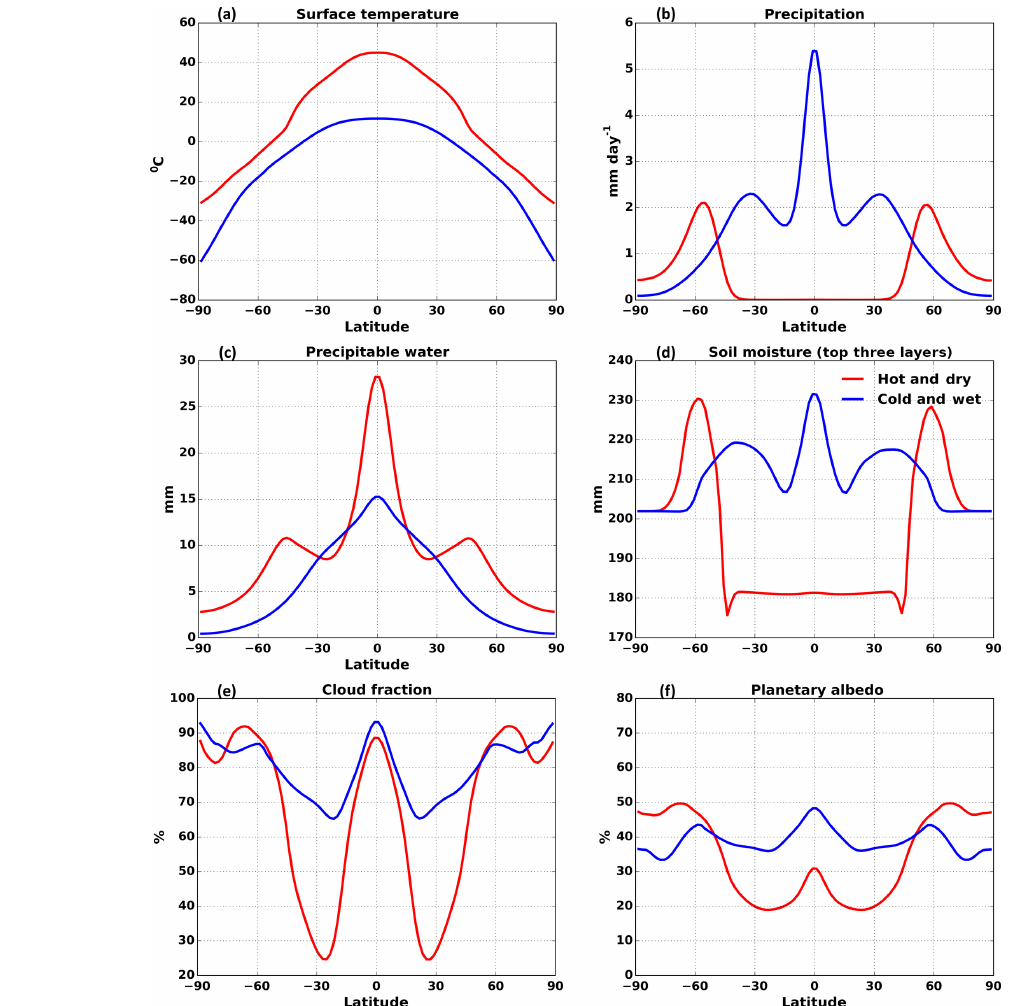
Figure 8. Annual mean meridional profiles as in Fig. 2 but with dark snow (snow albedo is the same as background soil albedo – DS simu-